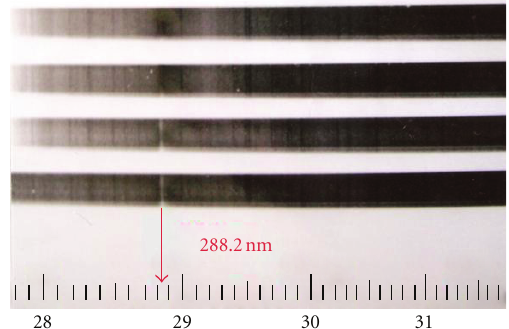
Figure 4: Discrete absorption and resonance fluorescence lines of silicon dioxide at 288.2